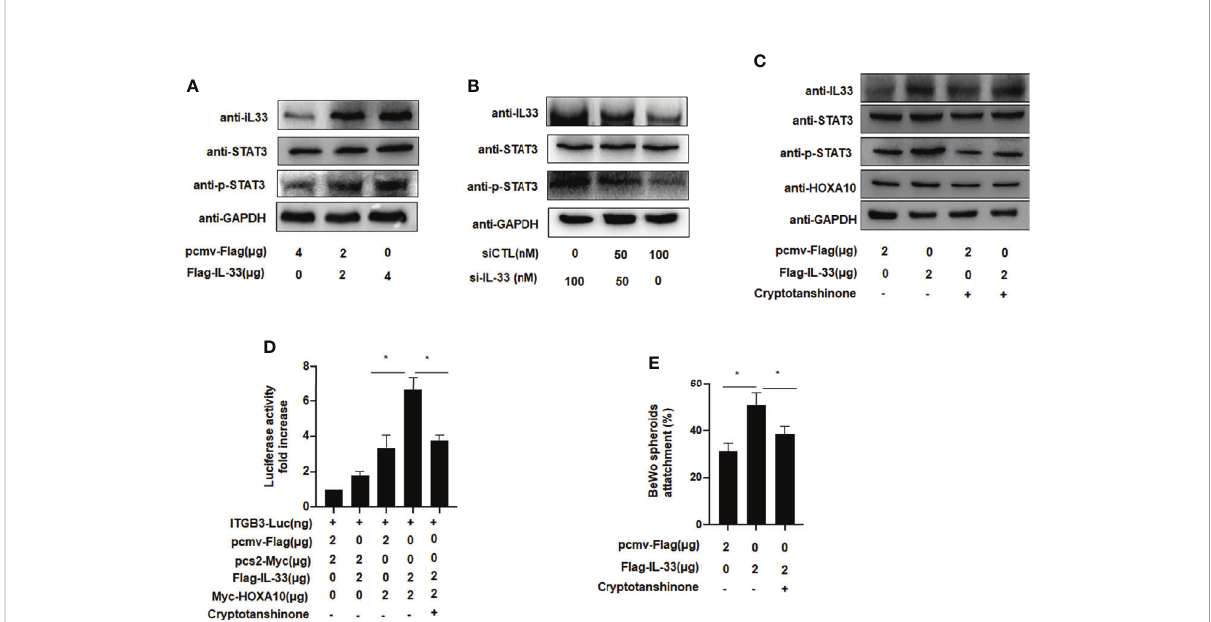
FIGURE 5 IL-33 enhances embryo implantation via phosphorylation of STAT3. (A) Ishikawa cells were transfected with Flag-IL33 (2 m g). IL33, STAT3 and p-STAT3 protein levels were analyzed by western blot analysis. (B) Ishikawa cells were transfected with siIL33 (50 or 100 nM), Whole-cell lysates. were analyzed by western blot analysis with the indicated antibodies. (C) Ishikawa cells were administrated with cryptotanshinone (4.6 m M) for 8h before. the transfection of Flag-IL33 (2 m g), Whole-cell lysates were analyzed by western blot analysis with the indicated antibodies. (D) Ishikawa cells were administrated with cryptotanshinone (4.6 m M) for 8h before. the transfection of ITGB3-Luc, Myc-HOXA10 (2 m g), and Flag-IL33 (2 m g), as indicated. The luciferase activities were measured and are presented as fold induction. Values represent the mean ± SEM (n = 3), *p < 0.05. (E) Ishikawa cells were administrated with cryptotanshinone (4.6 m M) for 8h before the. transfection of Flag-IL33 (2 m g). BeWo spheroids (150 – 200 m m diameter) were attached to Ishikawa cells after 2 h of co-culture. Adhesion experiments with BeWo spheroids attached to the Ishikawa cell monolayer. The data are the average of three independent experiments. An ANOVA test was used to compare the percentage of the attached spheroids with each treatment in comparison to the control. The error bars indicate SD of three independent experiments. Values represent the mean ± SEM (n = 3), *p <